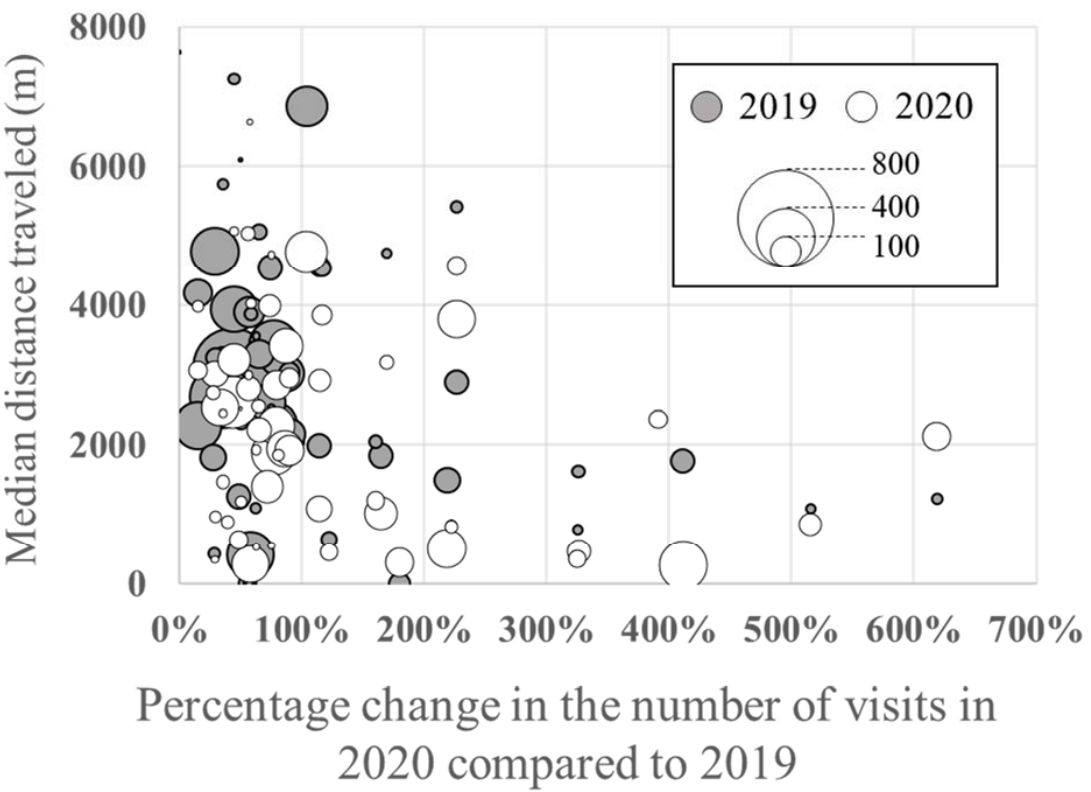
Figure 8. Relationship between the rate of increase/decrease in the number of visits to each greenspace in Kanazawa City in 2020 compared to 2019 and the average distance traveled from home. Note that a bubble size indicates the number of visits.